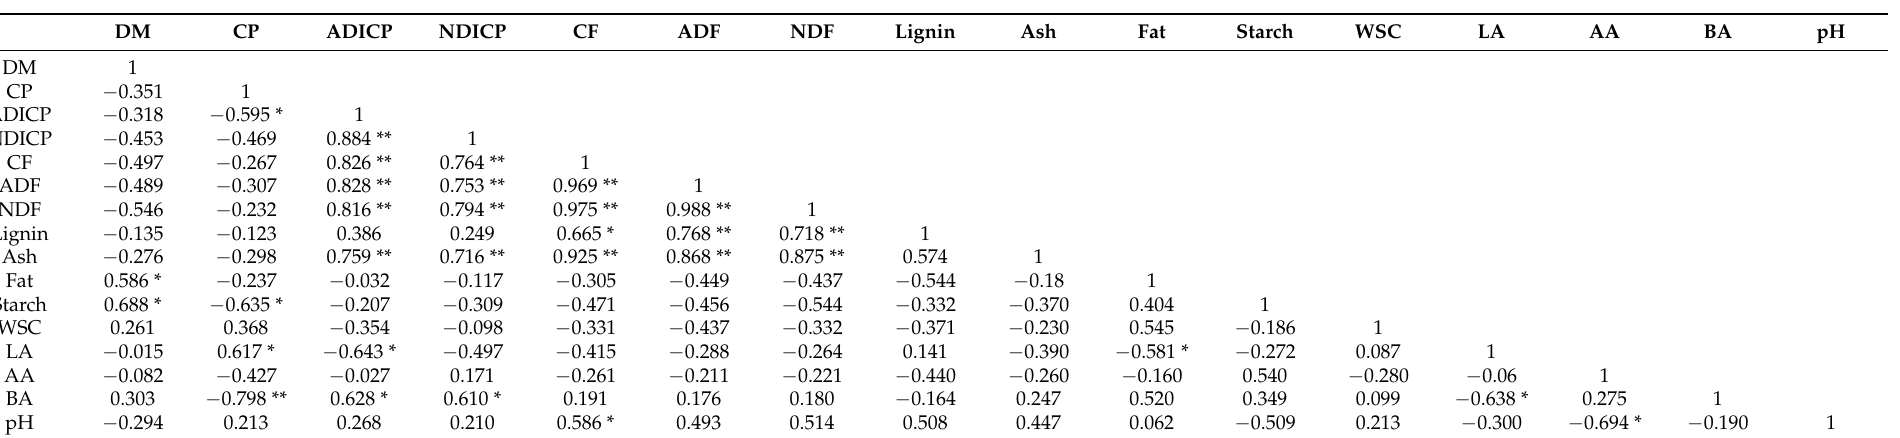
Table 2. Correlation analysis of various indexes of whole-plant corn